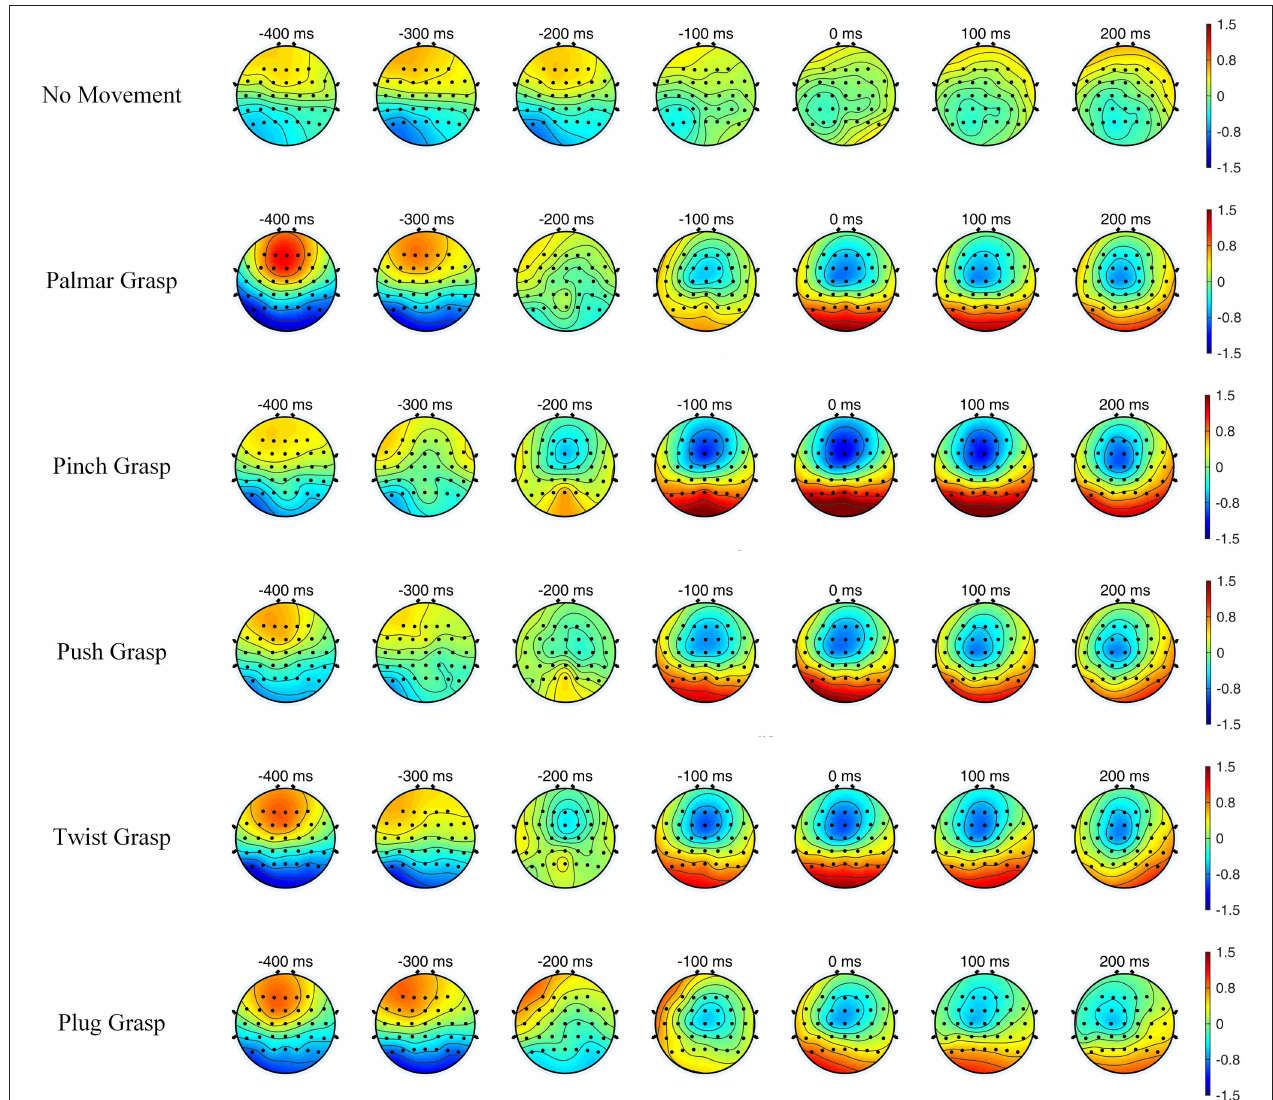
FIGURE 4 | The topographic maps of grand average electroencephalogram (EEG) amplitude over subjects and sessions for all conditions, with time of [ − 0.4, 0.2]